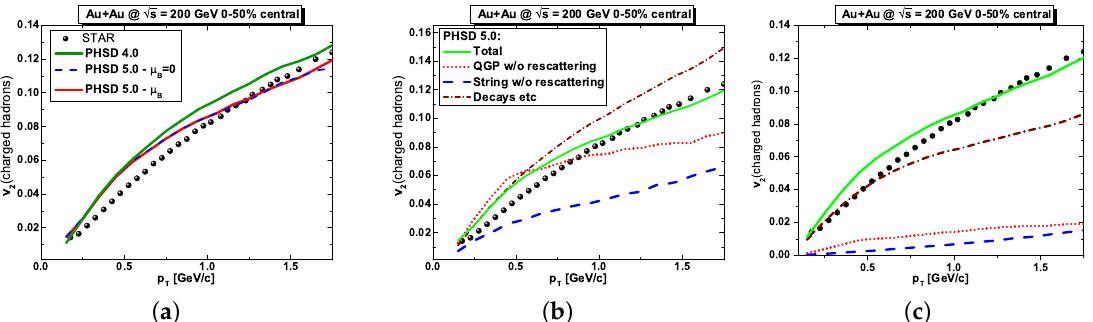
Figure 7. Elliptic flow of charged hadrons as a function of p T for 0–50% central Au+Au collisions at √ s NN = 200 GeV. The line description is similar to Figure 6. The channel composition of v 2 for PHSD5.0—with cross sections and parton masses evaluated at the actual chemical potential µ B in each individual space-time cell—is shown in the middle plots ‘(b)’ of Figures 6 and 7. We sorted the particles according to their production channels into three parts: the red dotted line corresponds to the final hadrons coming from the QGP without rescattering in the hadronic phase, the blue dashed line indicates the v 2 of hadrons coming from strings (without further rescattering) while the brown dot-dashed line shows the v 2 of hadrons coming from mesonic and baryonic resonance decays. One can see a large difference between the averaged elliptic flow for the different channels: the v 2 of hadrons from string decay is the lowest since string production occurs dominantly at the initial phase of the heavy-ion collision; the v 2 of hadrons from the QGP is the largest versus η as follows from the middle plot ‘(b)’ of Figure 6. However, this is mainly due to the low p T hadrons which give a larger contribution to v 2 ( η ) —cf. the middle part ‘(b)’ of Figure 7. Here, the high p T hadrons from the QGP show a lower v 2 than those coming from strings or resonance decays. The right parts ‘(c)’ of Figures 6 and 7 present the individual contributions to v 2 including their relative weights to the total v 2 . It shows that the properly weighted channel decomposition of v 2 looks rather different—the contribution of the hadrons from the QGP is now small since most of them rescatter in the hadronic phase, i.e., the relative fraction of hadrons directly coming from